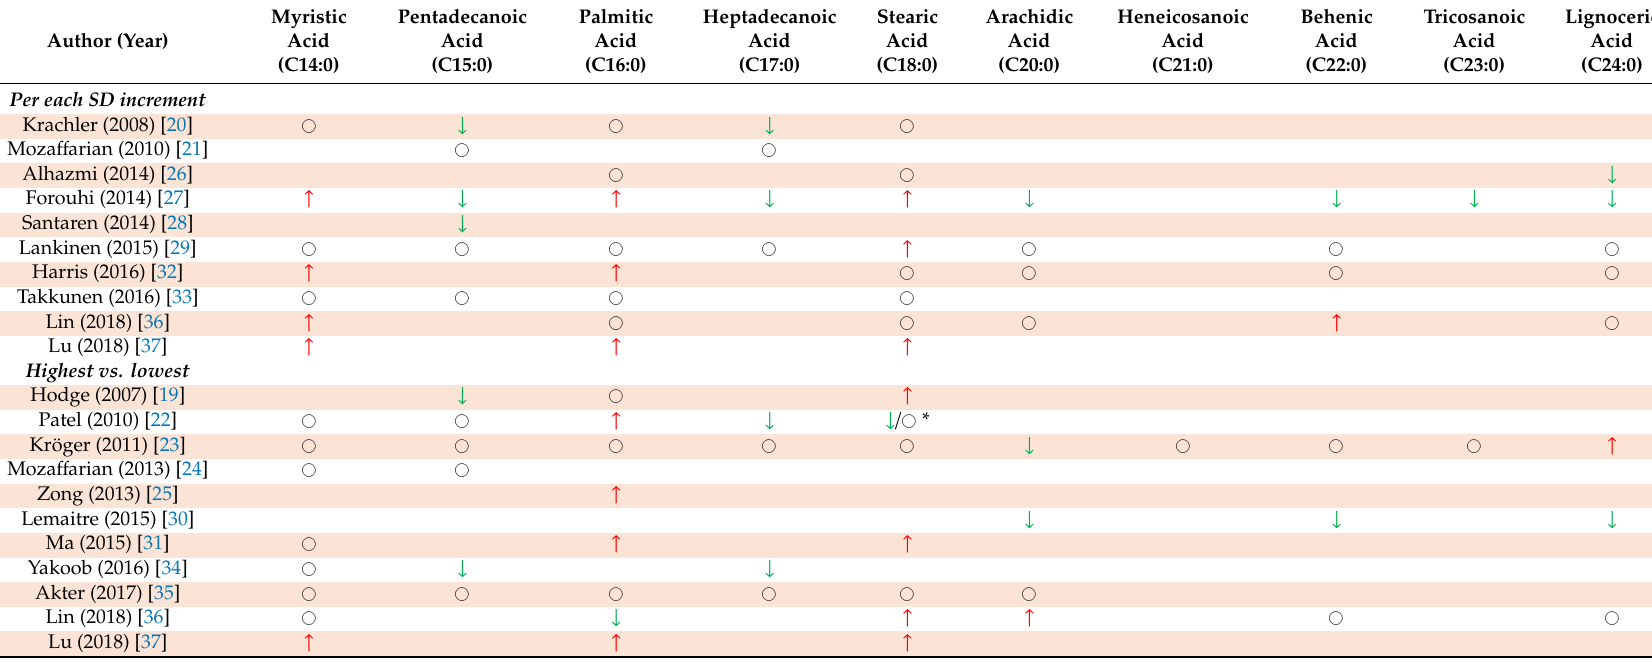
Table 2. Study-specific results of individual SFAs and incident